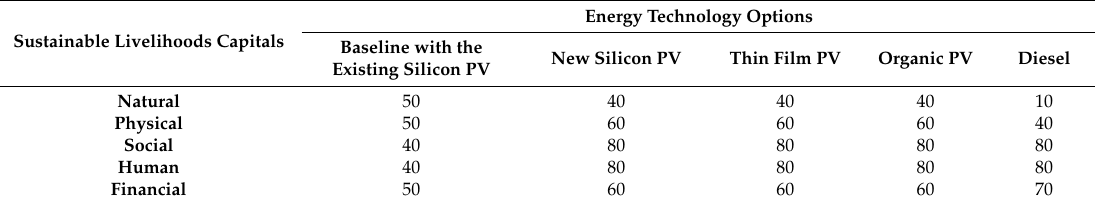
Table 2. Multicriteria payoff matrix: impact of energy technologies on sustainable livelihoods